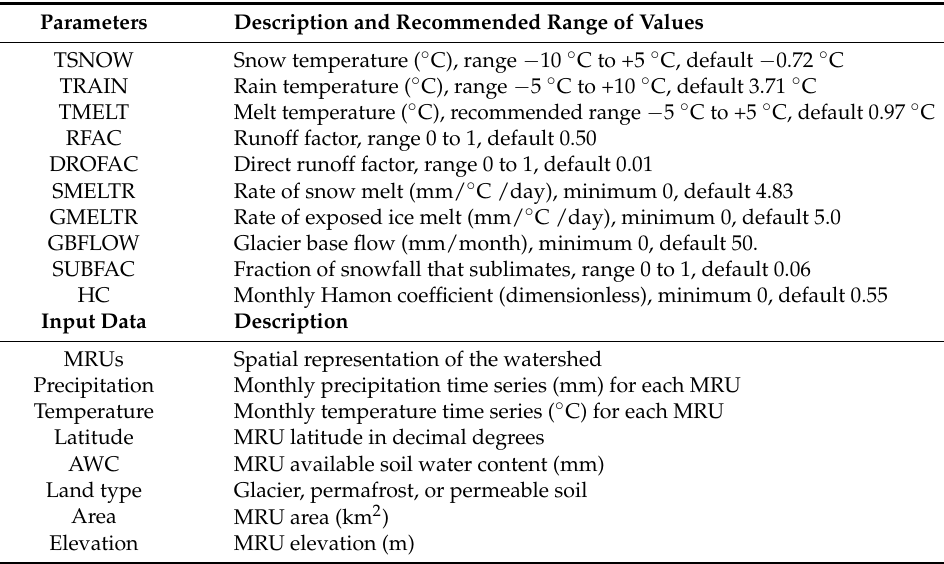
Table 3. The MWBMglacier parameters and input data